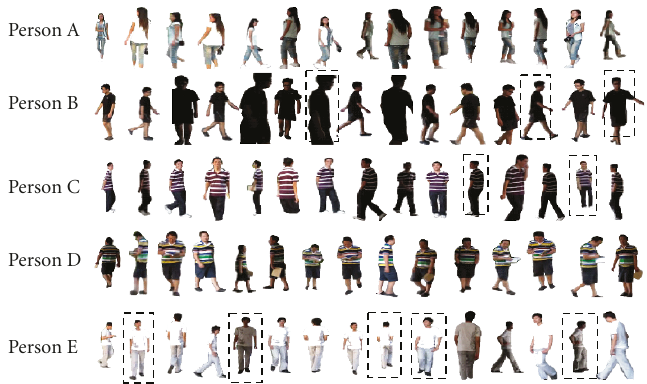
Figure 14: True trajectories of persons. Missing detections are depicted by dashed boxes. Table 3: Mean of the accuracy of inference algorithms under di ff erent number of observations (%). No.